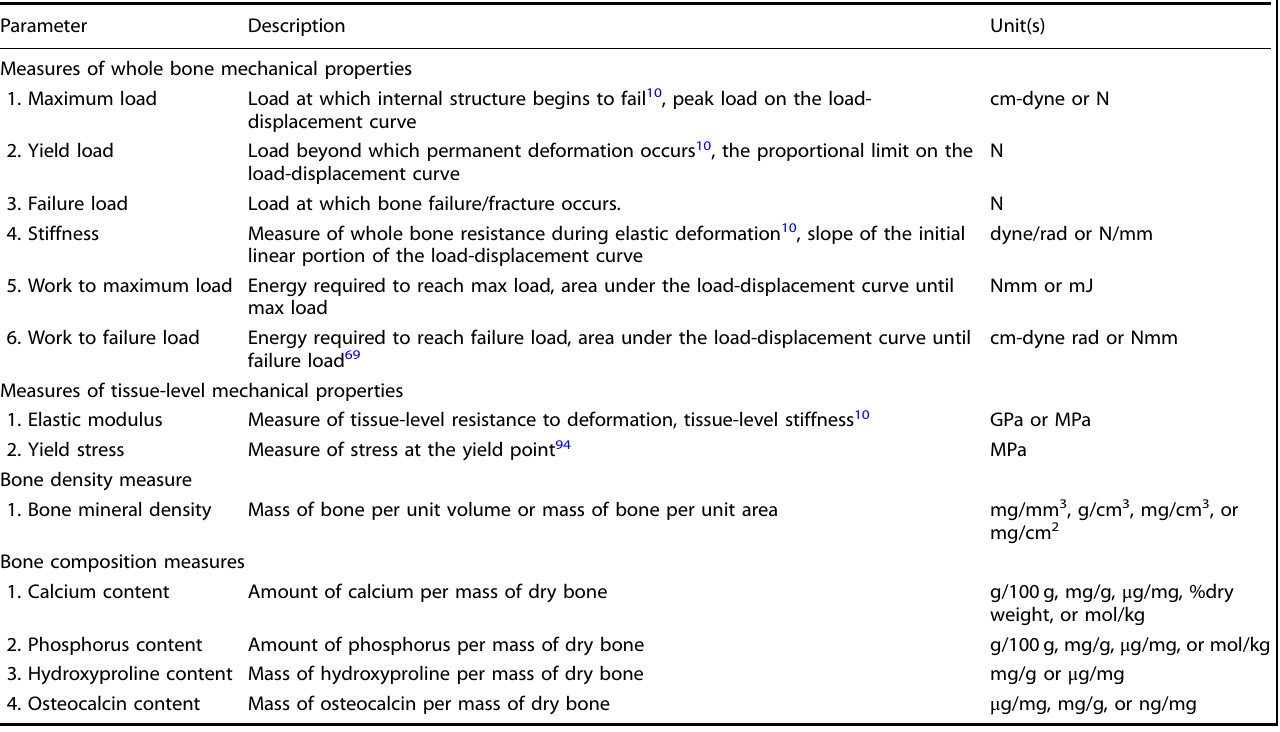
Table 1. Included bone properties for